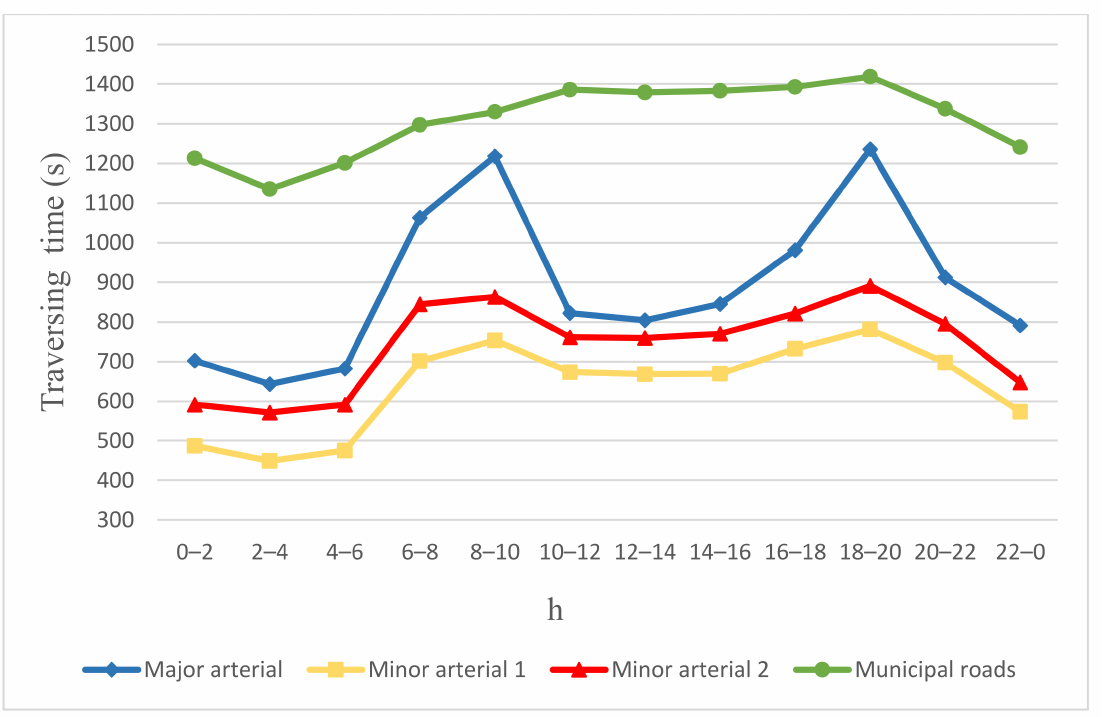
Figure 4. Illustration of traversing time of a PEV in the original